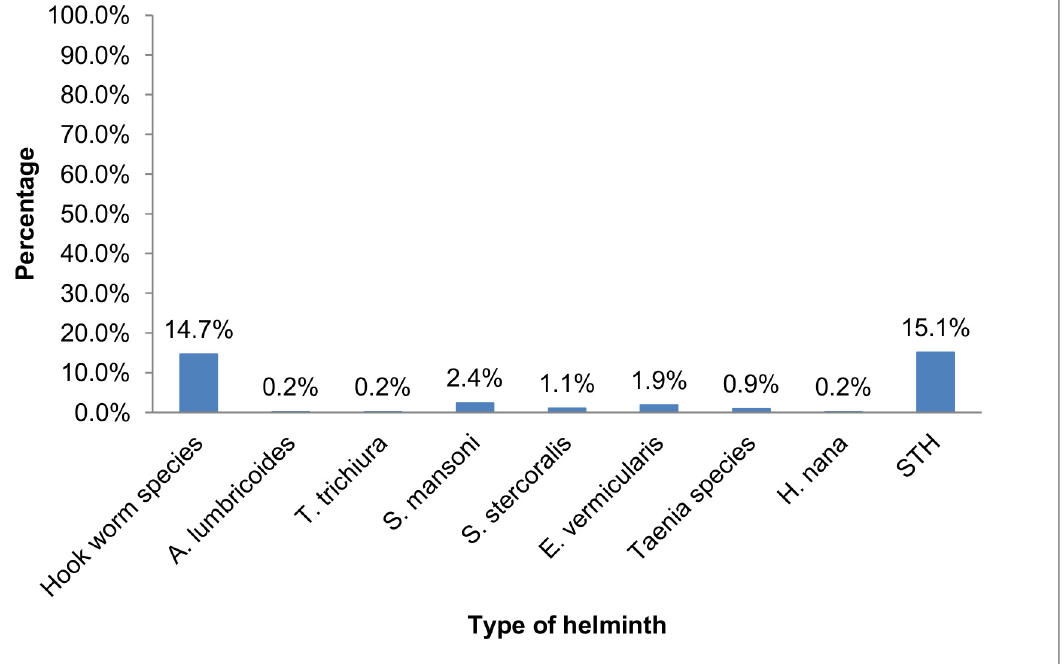
Fig 1. Proportion of helminthic infections among clients attending Anbesame health center, South Gondar, 2015. STH: Soil Transmitted Helminths